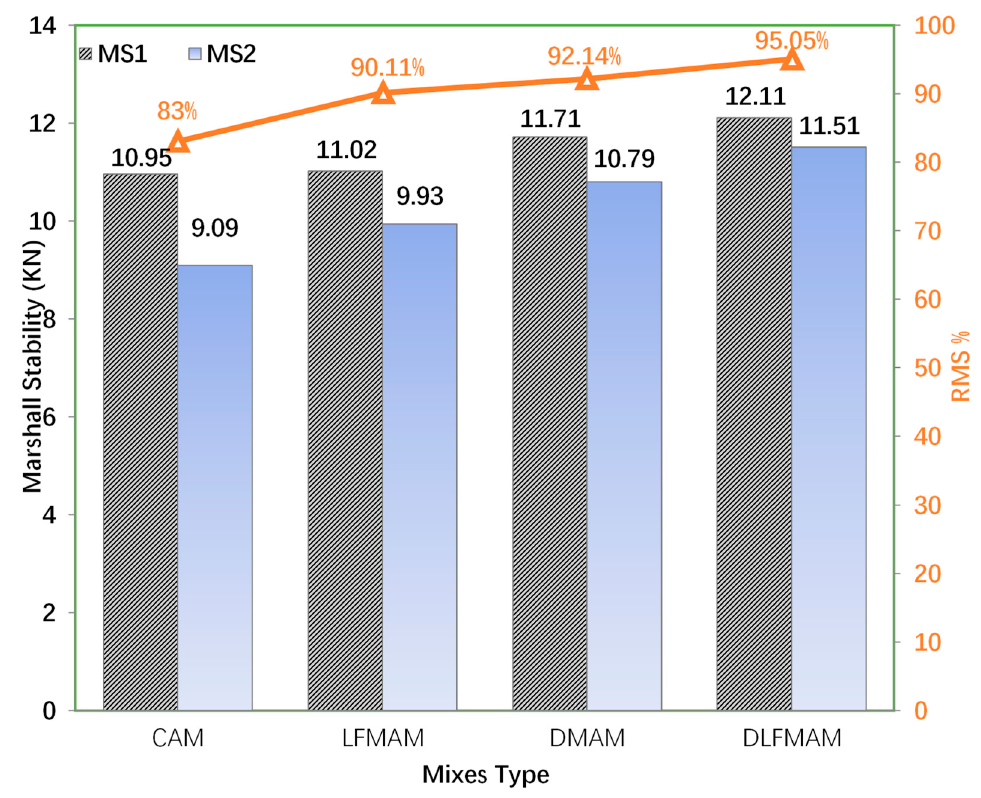
Figure 8. Results of the Immersion Marshall Stability test.